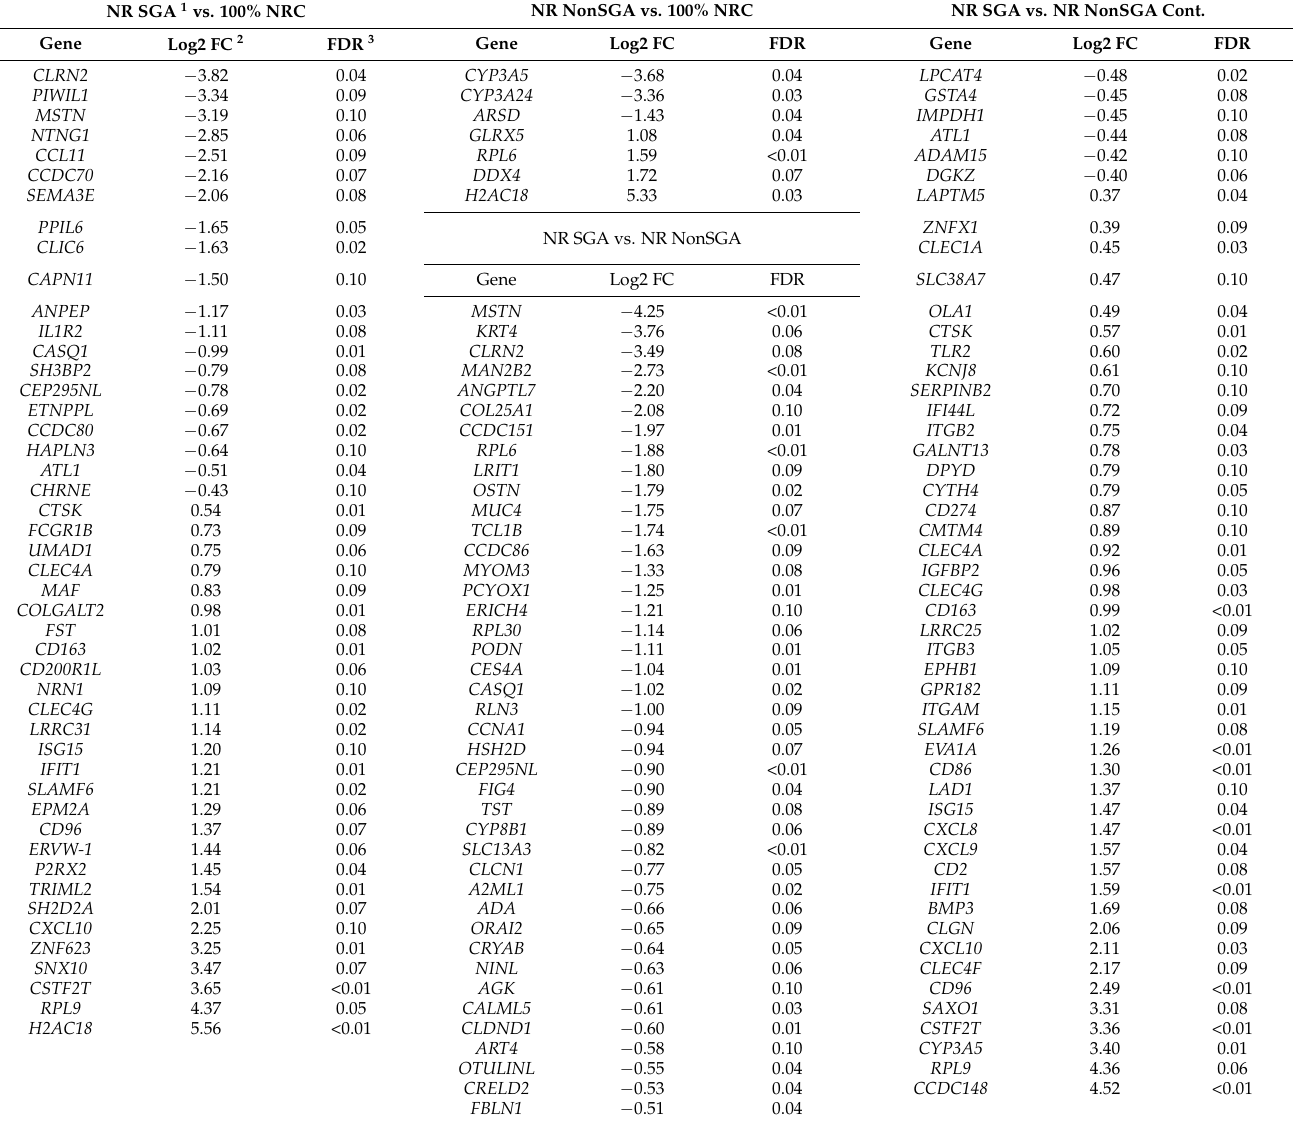
Table 2. Differentially expressed genes in placentomes at day 135 of